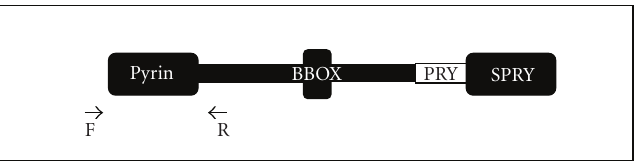
Figure 1: Diagram depicting the conserved domains of the human MEFV protein. Arrows indicate genomic localization of primers used for pyrin domain amplification.